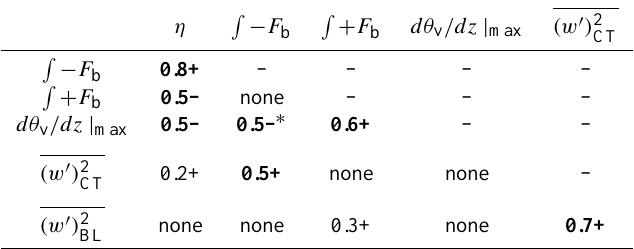
Table 2. Summary of correlations among parameters that relate to cloud top entrainment. All values are of the correlation coefficient R 2 and the sign (+ or − ) after the value denotes whether the correlations are positive or negative. Values in boldface highlight the strongest correlations. The value denoted by ∗ is obtained by throwing out one outlier (see text for details); R 2 = 0 . 2 if the outlier is